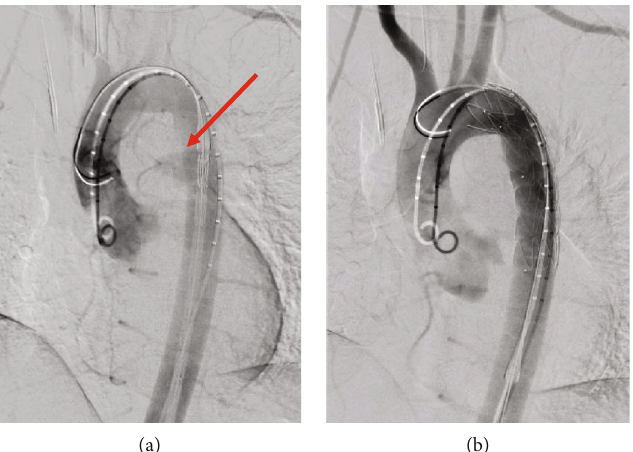
Figure 3: Intraoperative digital subtraction angiography during TEVAR. (a) Prestent deployment showing real time extravasation of contrast (red arrow). (b) Postthoracic stent deployment with successful endovascular sealing.